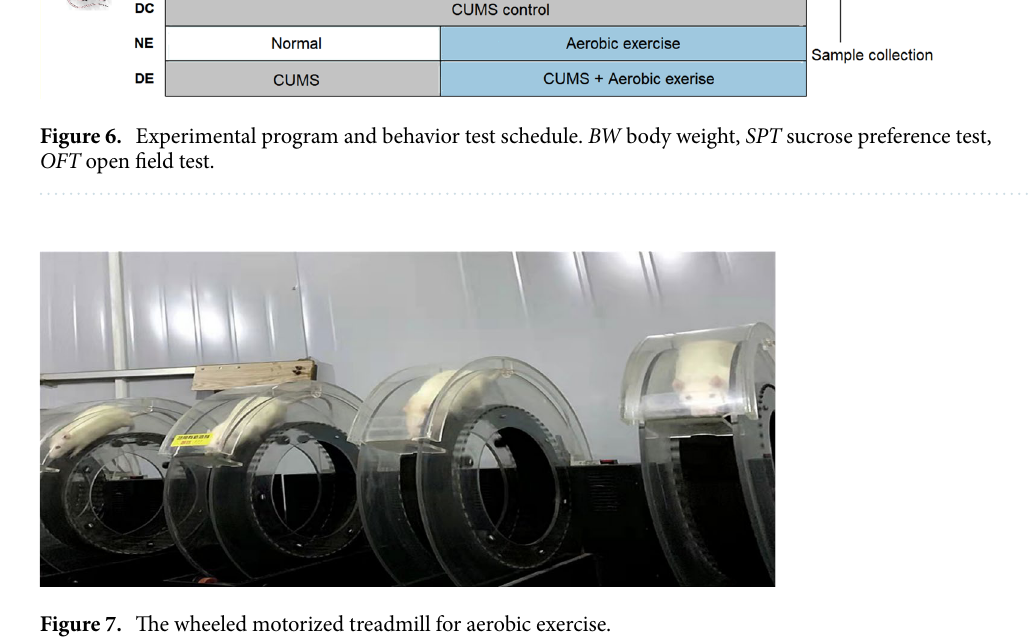
Figure 7. The wheeled motorized treadmill for aerobic